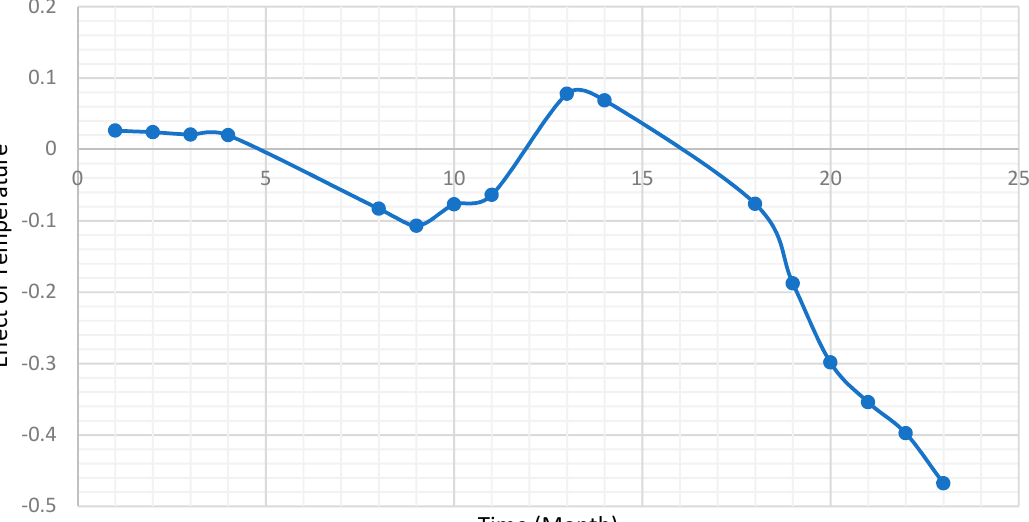
Infrastructures 2019 , 4 , x FOR PEER REVIEW